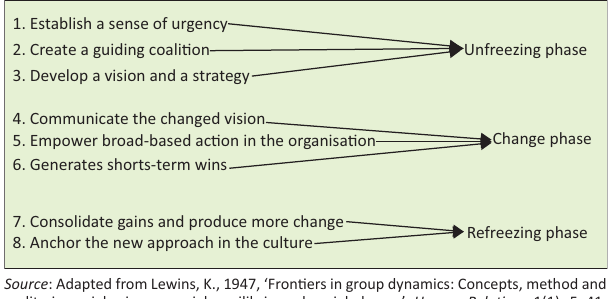
FIGURE 3: Three-stage model for managing